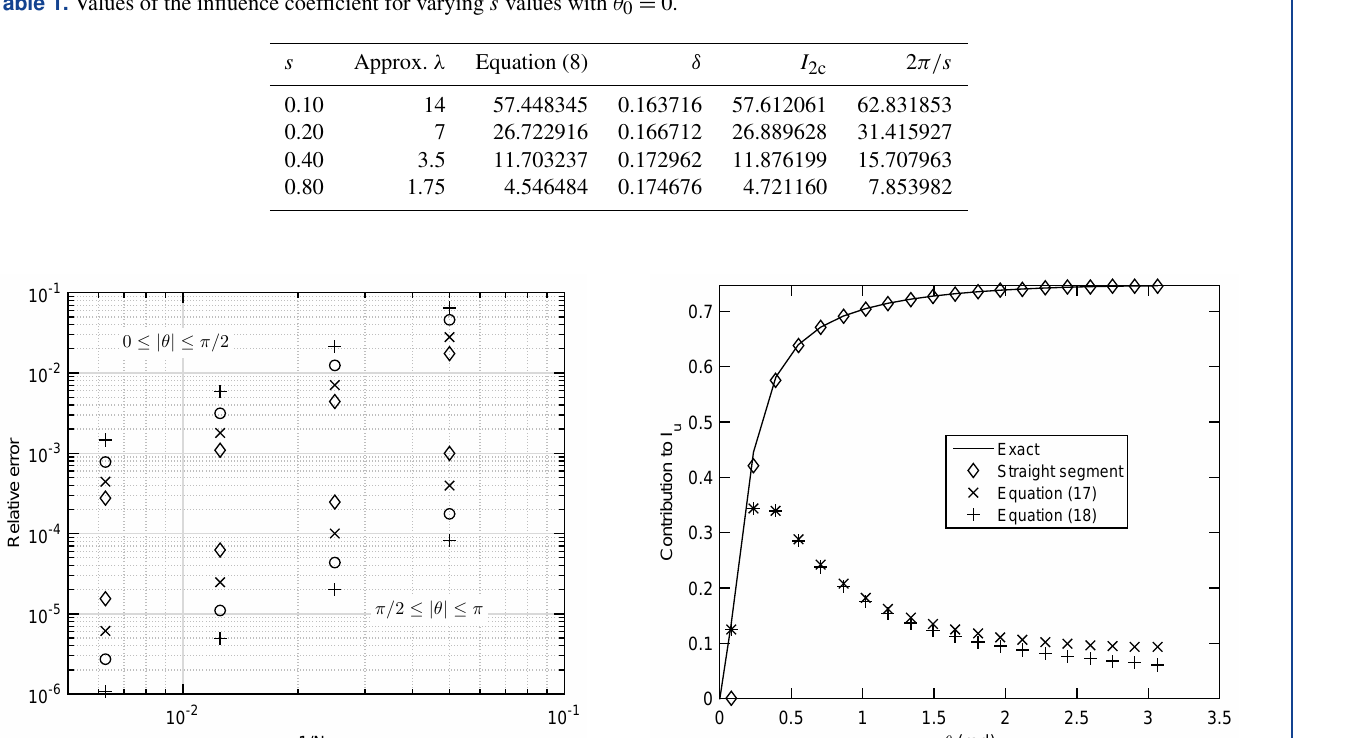
Table 1. Values of the influence coefficient for varying s values with θ 0 = 0.